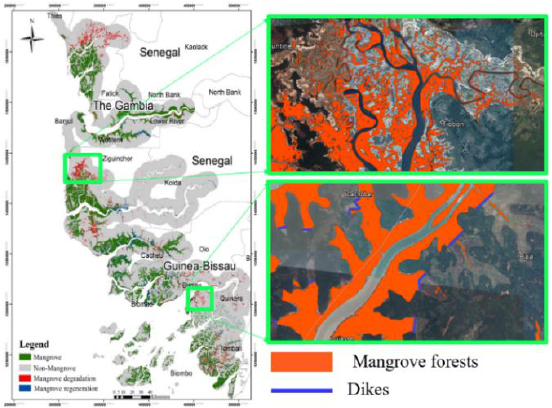
Figure 7. Mangrove deforestation based on native communities’ activities and drought and salt